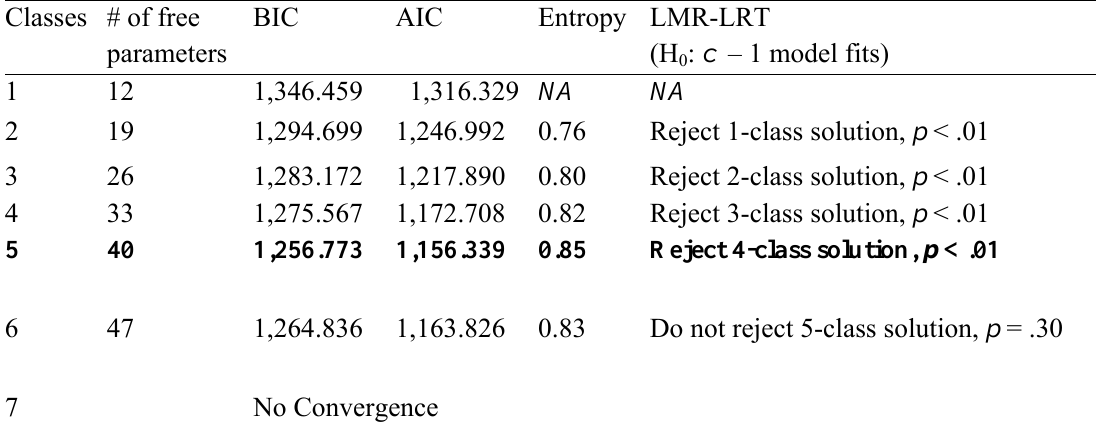
Study One Summary Statistics for Model Fit of Latent Class